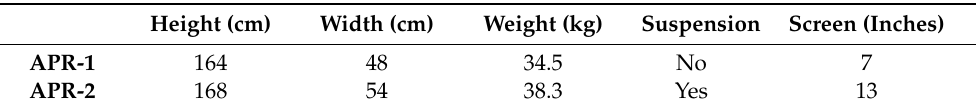
Table 1. Physical specifications of the two APR